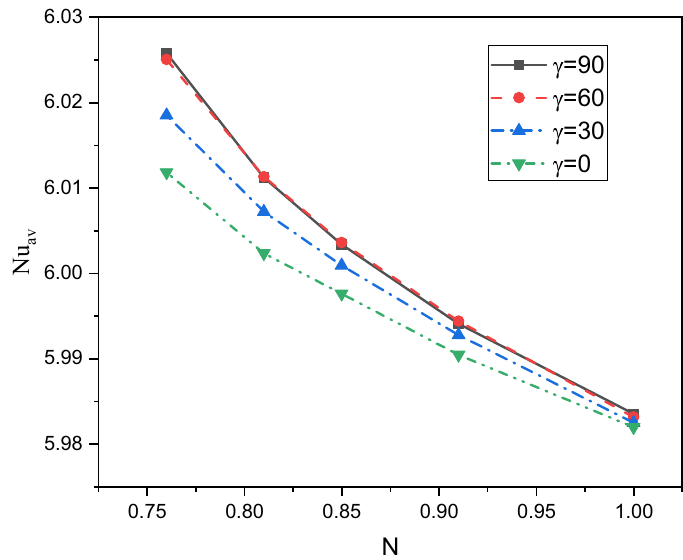
Figure 8. Impacts of the power-law index N and inclination angle γ on the average Nusselt number at Ra = 10 5 , Da = 10 − 3 , b = 0.6, d = 0.5, Ma = 1000, β = 0.95, τ = 1, φ = 2%, Rd = 1, � = 10 − 4 .